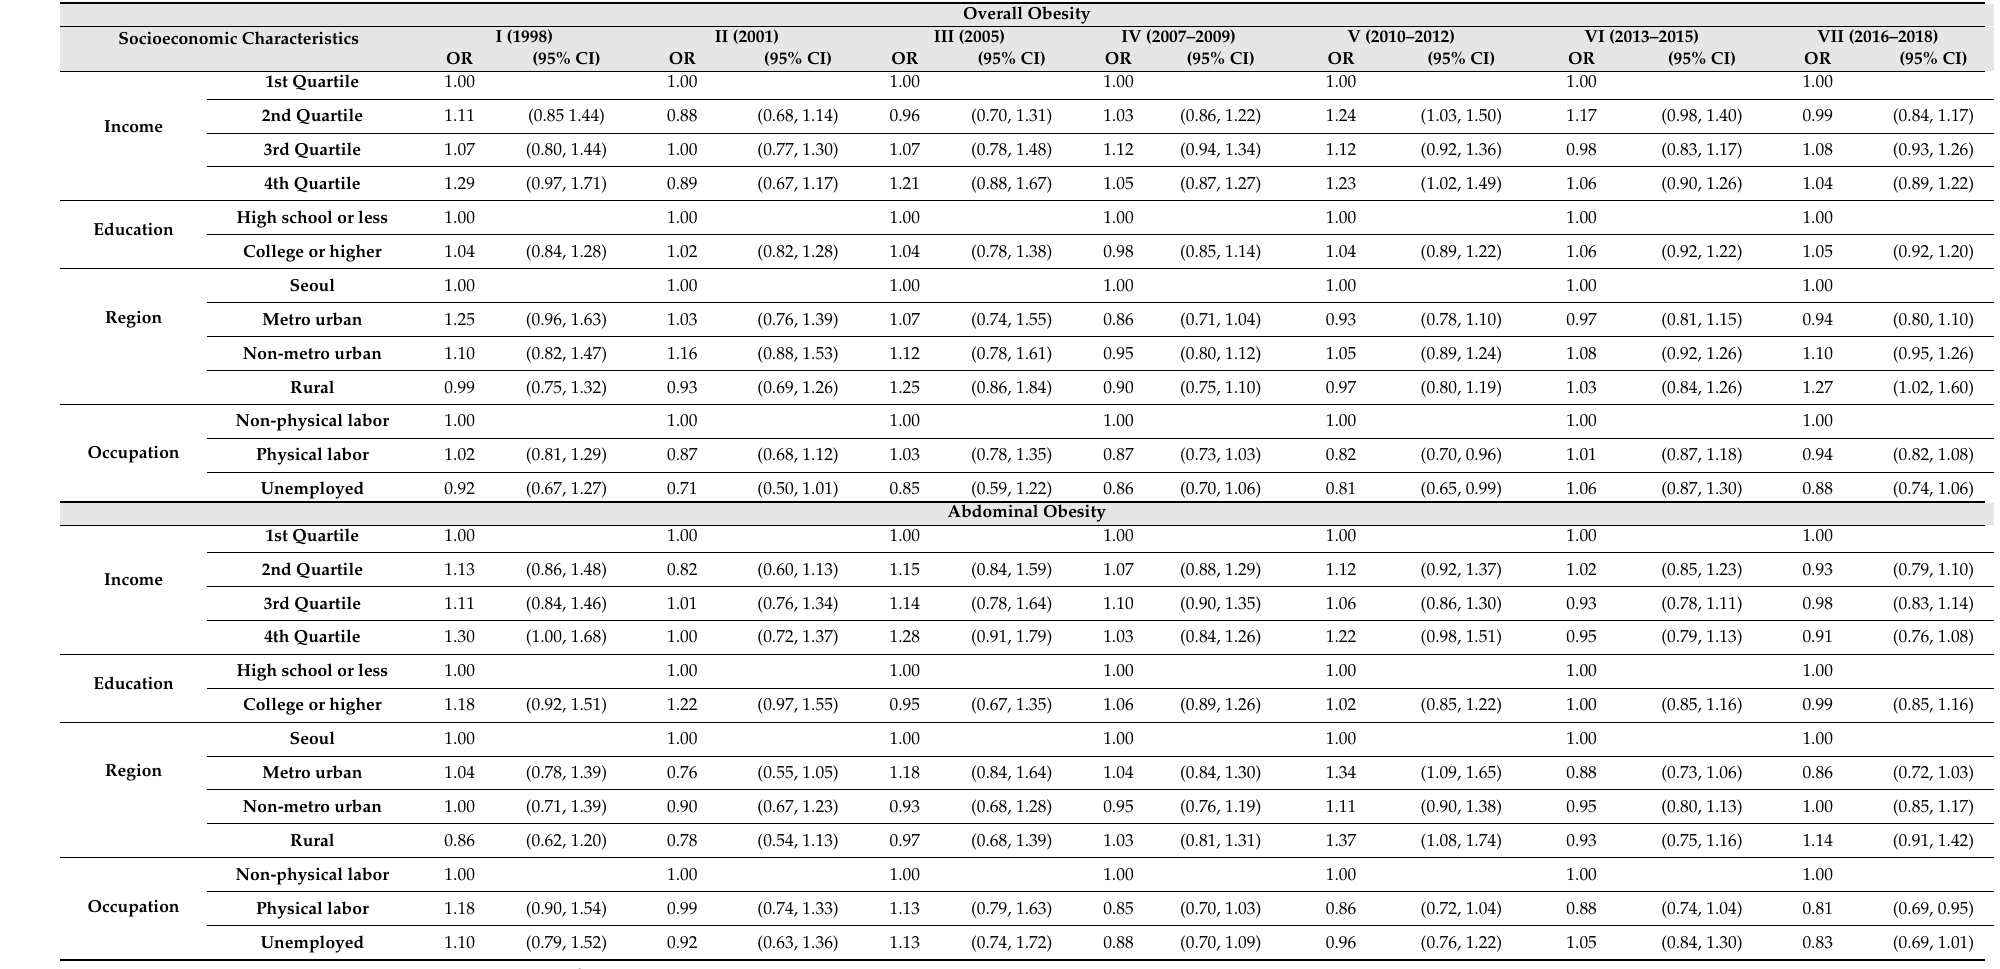
Table 2. Odds ratios (OR) and 95% confidence intervals (CI) for the associations of socioeconomic factors (income, education, region, occupation) with overall and abdominal obesity prevalence in men: the KNHANES